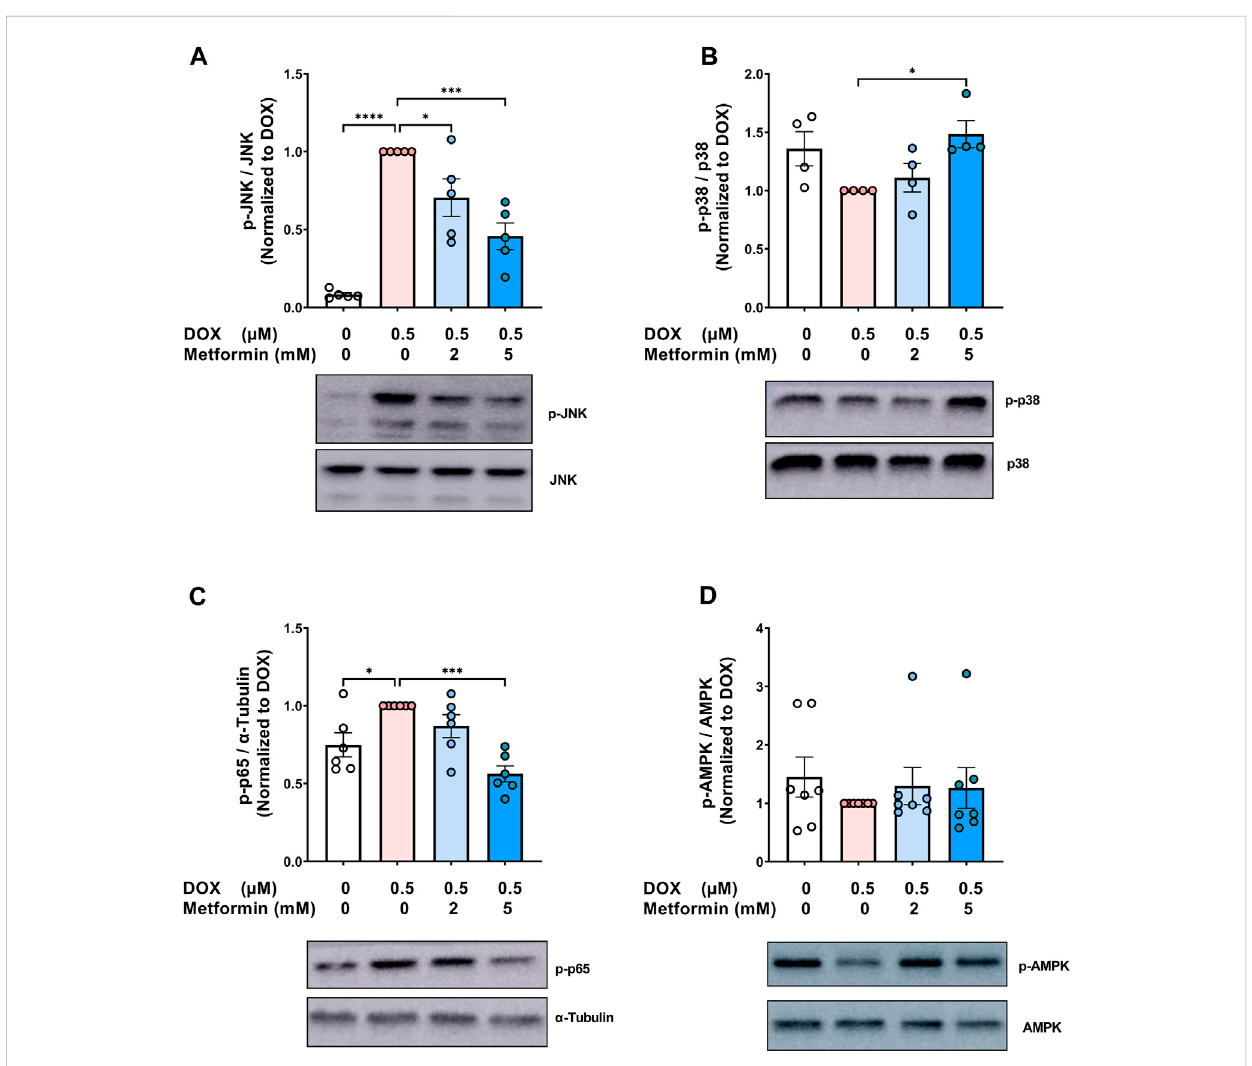
Signaling pathways associated with the protective effect of metformin on endothelial senescence in HUVECs. HUVECs were treated for 24 h with 0.5 µM DOX ± metformin (2 and 5 mM, added 24 h before DOX). Thereafter, DOX was removed and the cells were incubated in DOX-free media with or without metformin for anadditional72 h.Protein expressionsof phospho- (A) JNK, (B) p38, (C) NF- κ Bp65,and (D) AMPK (n =4 – 7)werequanti fi edusing western blot.Representativeimagesofwestern blots areshown. Values werenormalizedto totalproteinor α -tubulinand expressed relativetocells treated with DOX alone. Expressed values are presented as mean ± SEM. Data were analyzed by one-way ANOVA followed by a Dunnet ’ s multiple comparisons test (Figure 4A,C) or non-parametric Kruskal – Wallis tests followed by Dunn ’ s post hoc test (Figure 4B,D); * p < 0.05, *** p < 0.001, **** p <